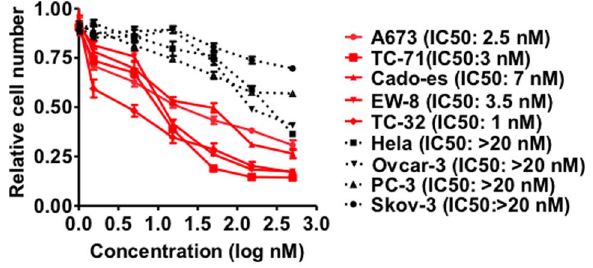
Figure 5. Growth effects of actinomycin D on Ewing sarcoma and other cancer cell lines. Cells were treated with DMSO or actinomycin D for 44 hours. Viable cell number was determined with a MTT assay. Data plotted as mean + / 2 SD of sextuplets and are representative of 3 independent experiments.